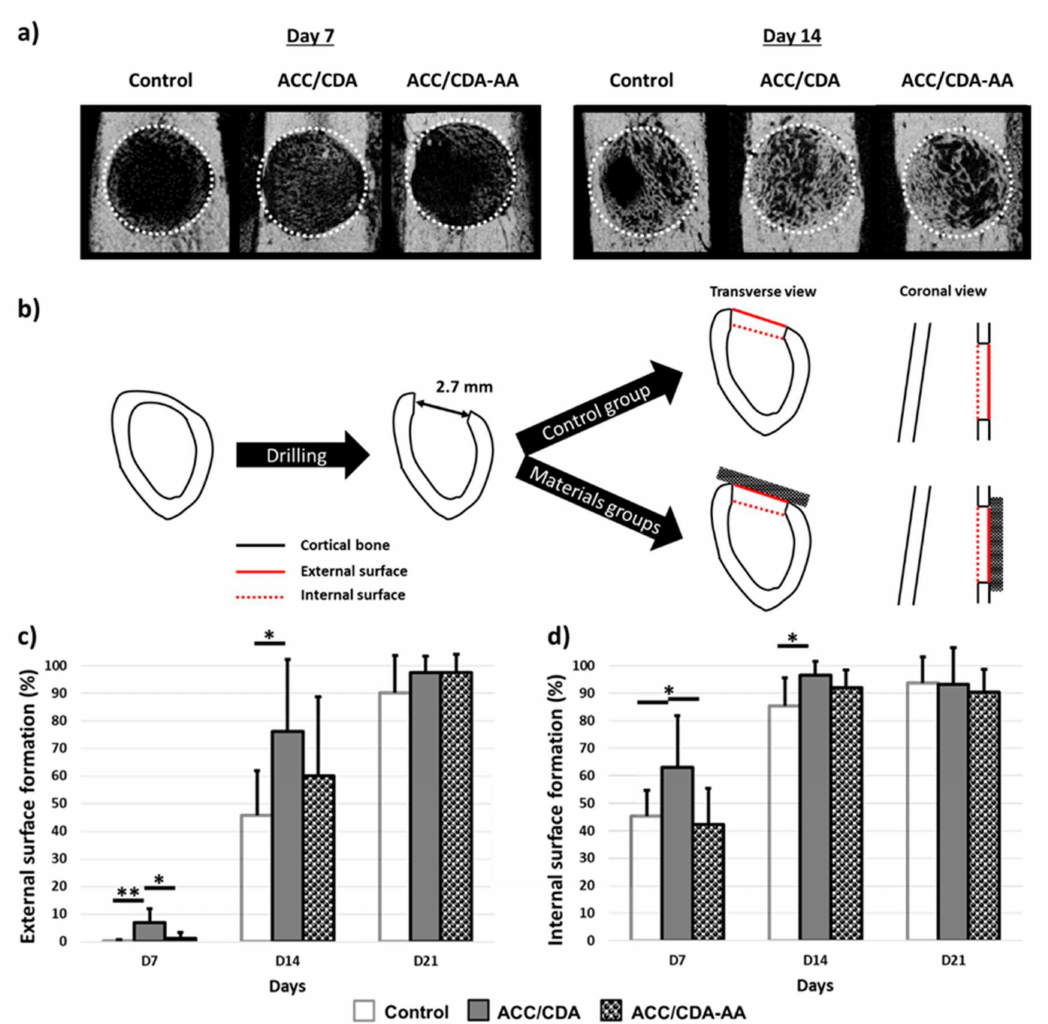
Figure 9. Further analysis of a cortical reconstruction at days 7, 14 and 21 post-surgery. ( a ) Higher magnification of µ -CT scan pictures of the representative samples for each group at days 7 and 14. Bone defect is delimited by a white dotted line. ( b ) Schemes describing the evaluation of the bone formation at the external and internal surfaces of the cortical bone. ( c , d ) Quantification of new cortical bone formation ( c ) at the external surface and ( d ) at the internal surface. Mean ± standard deviation, * p < 0.05, ** p <